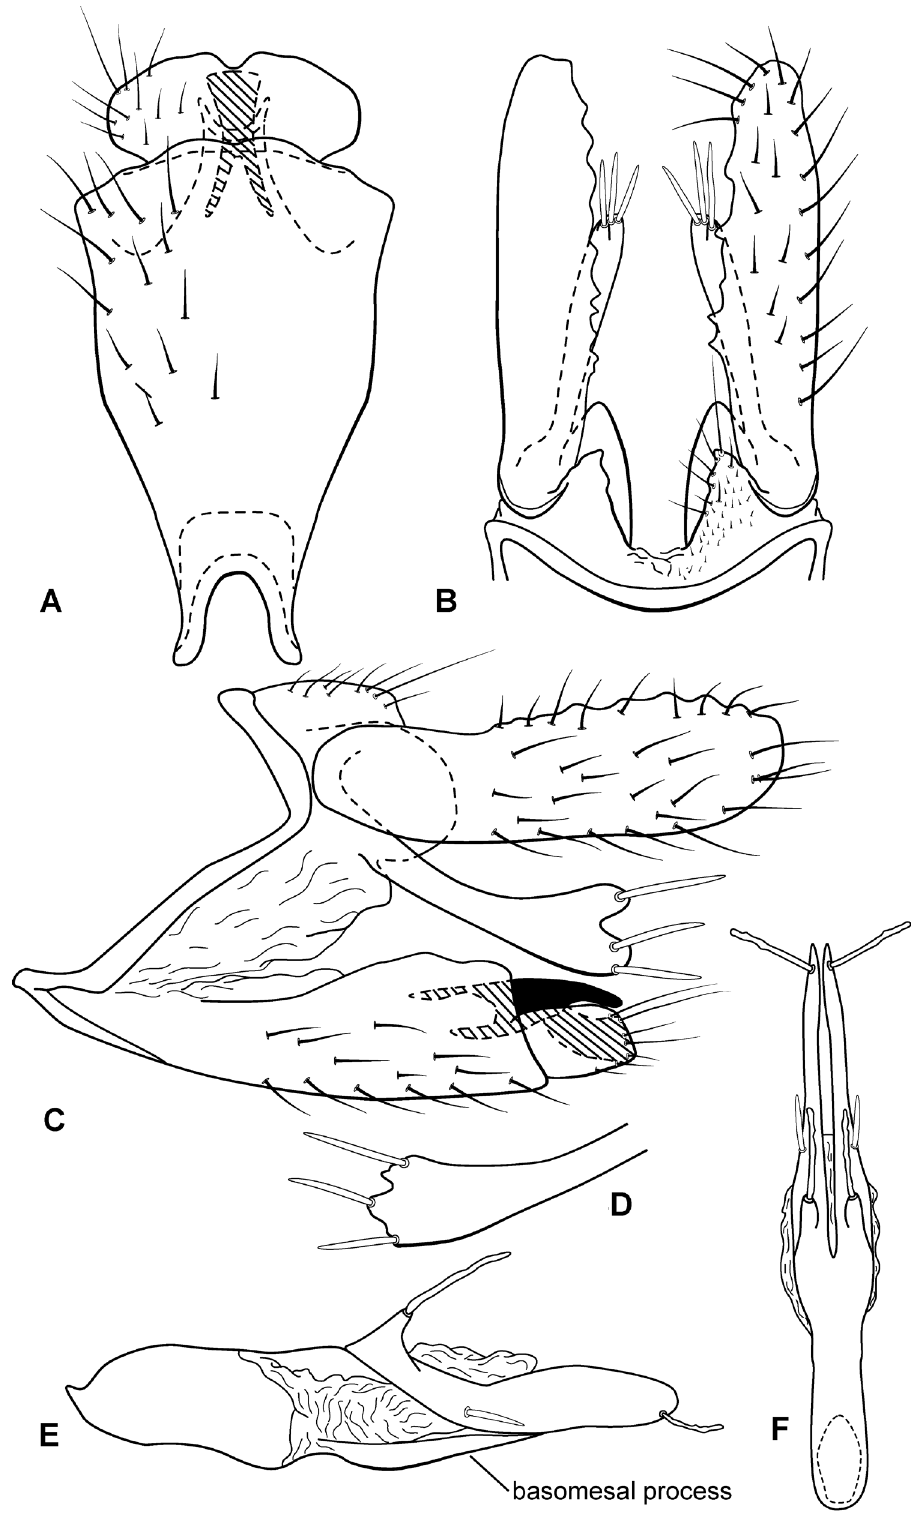
Fig. 3. Austrotinodes berthalutzae sp. nov., male genitalia. A . Ventral view. B . Dorsal view. C . Left lateral view. D . Right apex of intermediate appendage. E . Phallic apparatus, left lateral view. F . Phallic apparatus, dorsal